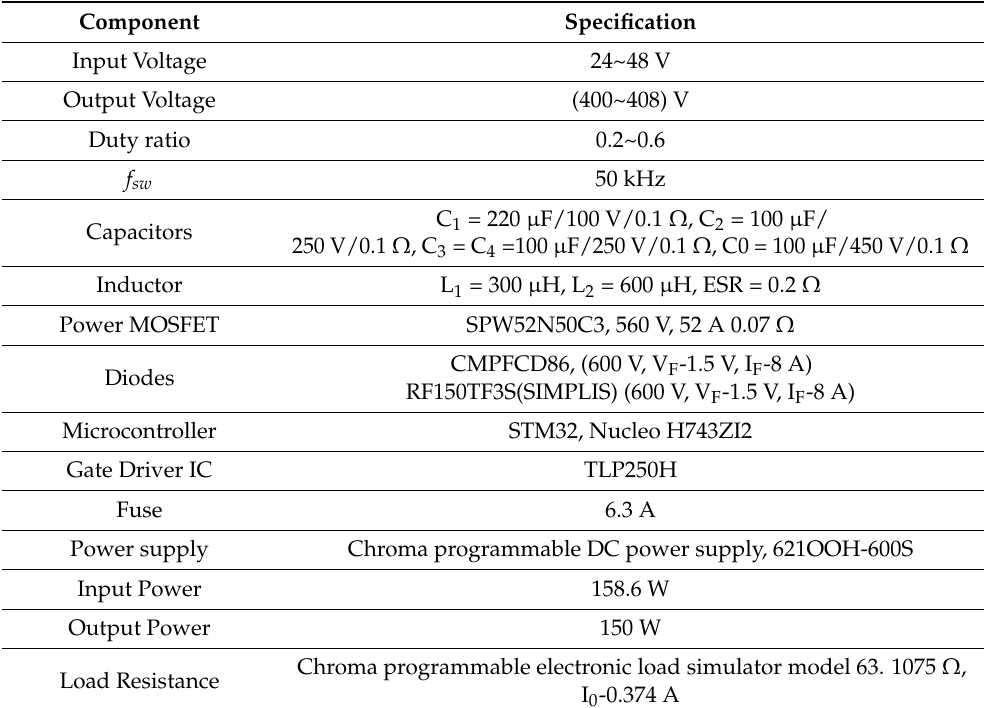
Table 2. Component specifications of the proposed converter.